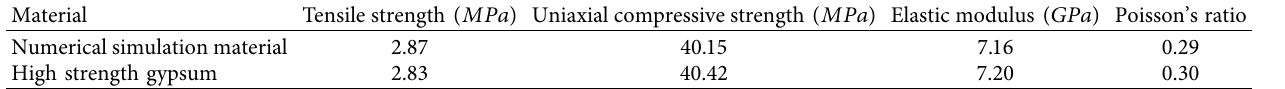
Table 2: Basic mechanical properties of numerical simulation materials.